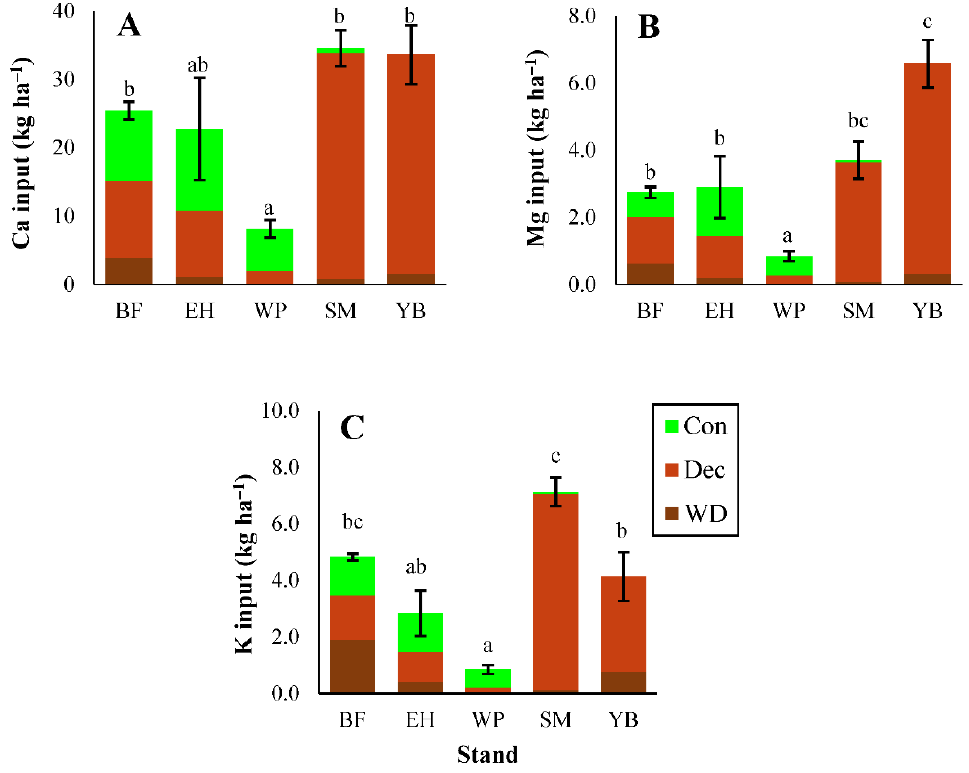
Figure 2. Inputs of calcium (Ca) ( A ), magnesium (Mg) ( B ), and potassium (K) ( C ) in each litterfall component (Con, Dec, WD). Different letters represent significant differences ( p < 0.05) in total litterfall inputs among stands. ANOVA test results shown in Table S3. Error bars indicate standard error (S. E.). For BF, EH, and YB, n = 3. For SM and WP, n = 5.